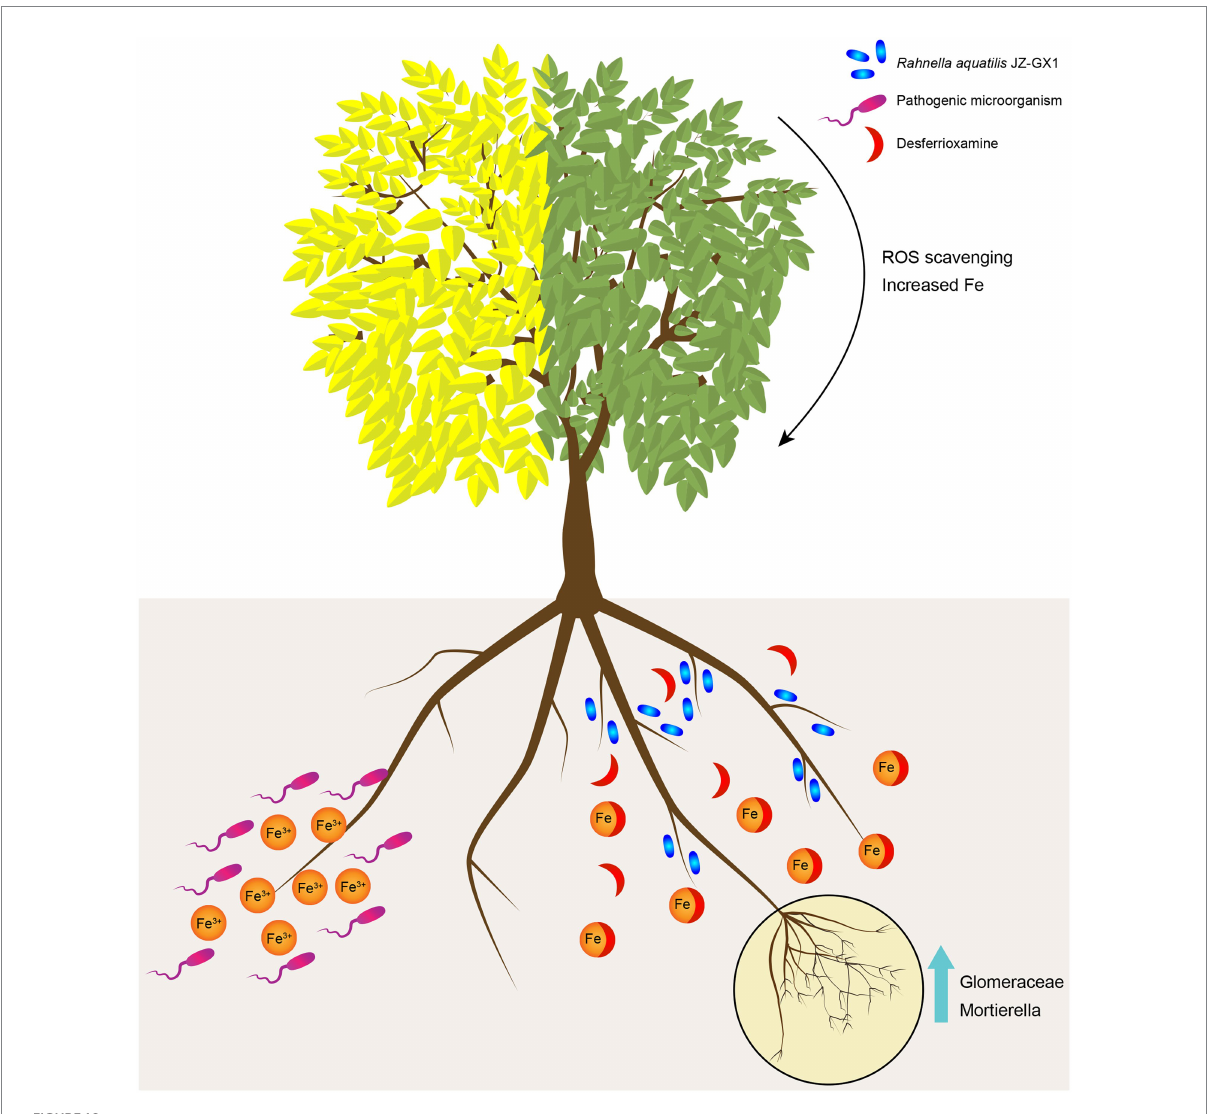
FIGURE 10 Putative model of the mechanism through which Rahnella aquatilis JZ-GX1 alleviates the iron deficiency-induced etiolation of Cinnamomum camphora by reprogramming the rhizosphere microbial community and increasing the content of DFO in soil. The JZ-GX1 strain secrete DFO